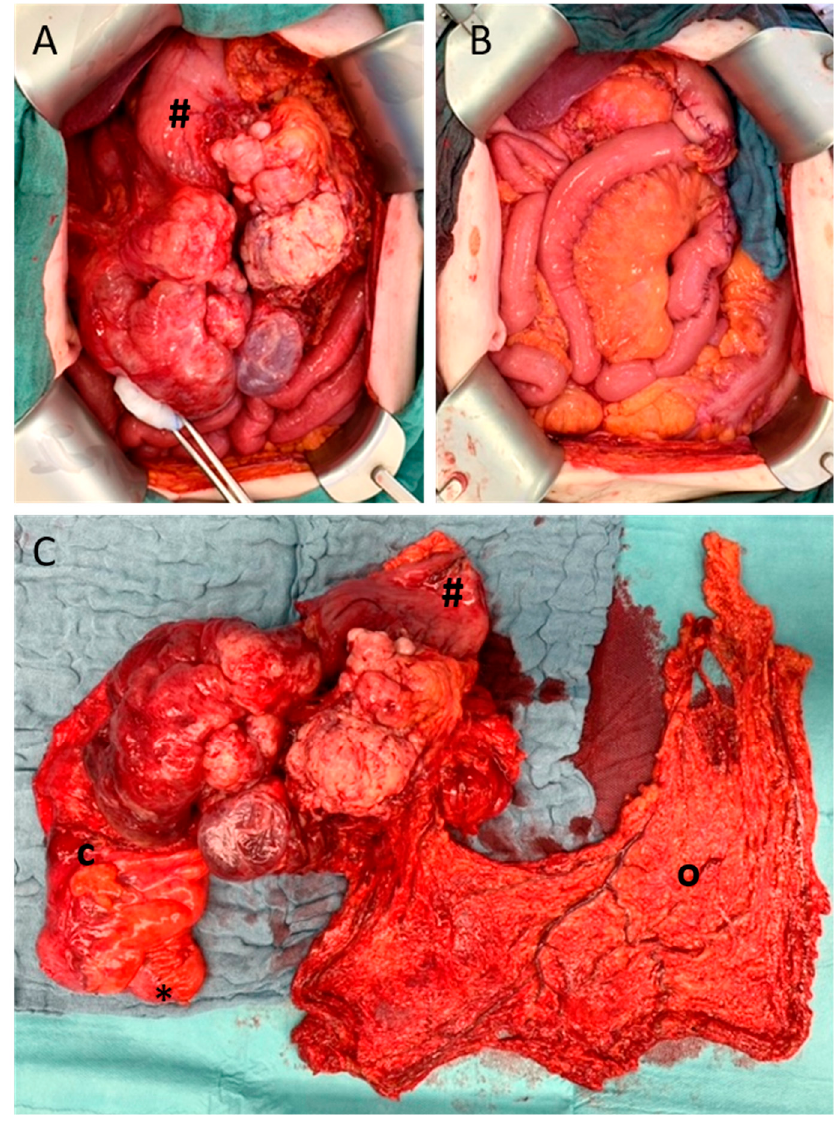
Figure 2. Example of palliative resection. Intraoperative findings of the previously mentioned 87-year-old male with pleomorphic sarcoma (Figure 1). ( A ) Surgical exploration showed diffuse peritoneal sarcomatosis and a massive tumor formation. ( B ) Palliative resection and reconstruction with gastrojejunostomy, Roux–en–Y reconstruction, and terminal ileostomy were performed, and the patient was discharged three weeks later. ( C ) The resected specimen contained the tumor with the infiltrated distal stomach (#) and ascending colon ( c ) and terminal ileum (*), as well as the greater omentum ( o